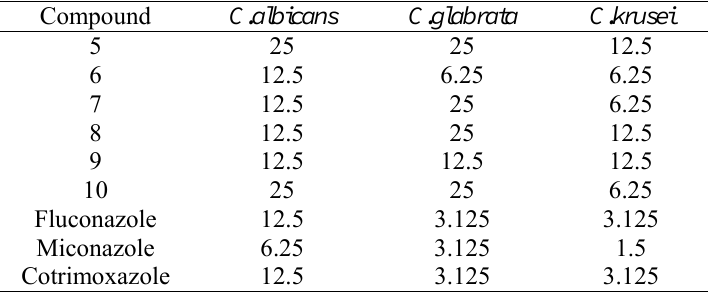
Table 1. Antifungal activities of the synthesized